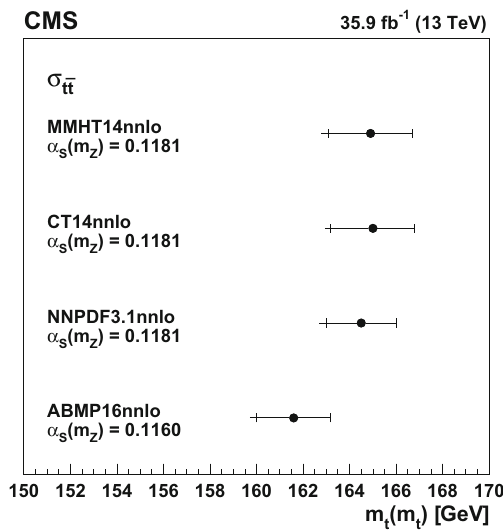
Fig. 12 Values of m t ( m t ) obtained from comparing the σ tt measure- ment to the theoretical NNLO predictions using different PDF sets. The inner horizontal bars on the points represent the quadratic sum of the experimental, PDF, and α S ( m Z ) uncertainties, while the outer horizon- tal bars give the total uncertainties